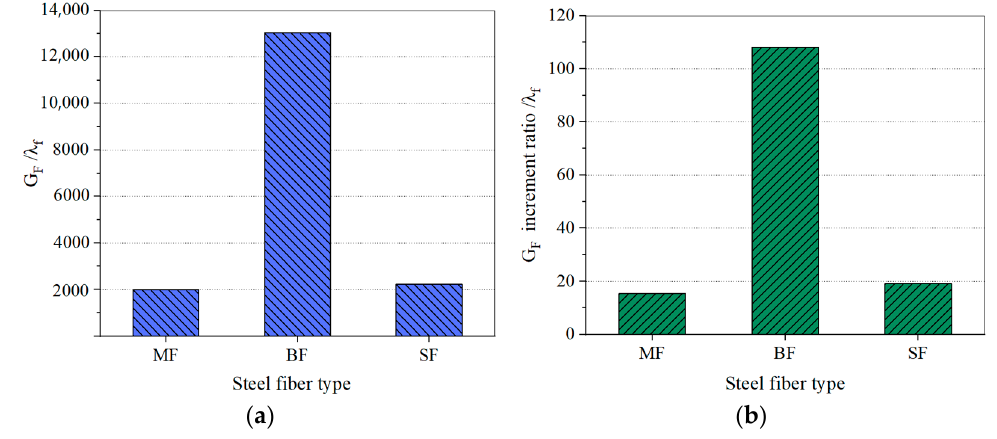
Figure 13. Influence of Steel Fiber Types on the G F ( a ) and G F Increment Ratio ( b ) of SFHSC.